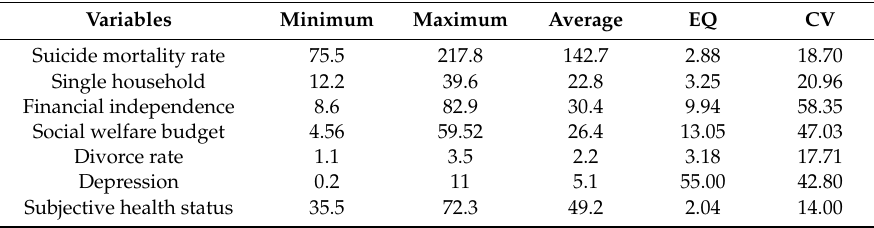
Table 2. Variations in suicide mortality and independent variables.